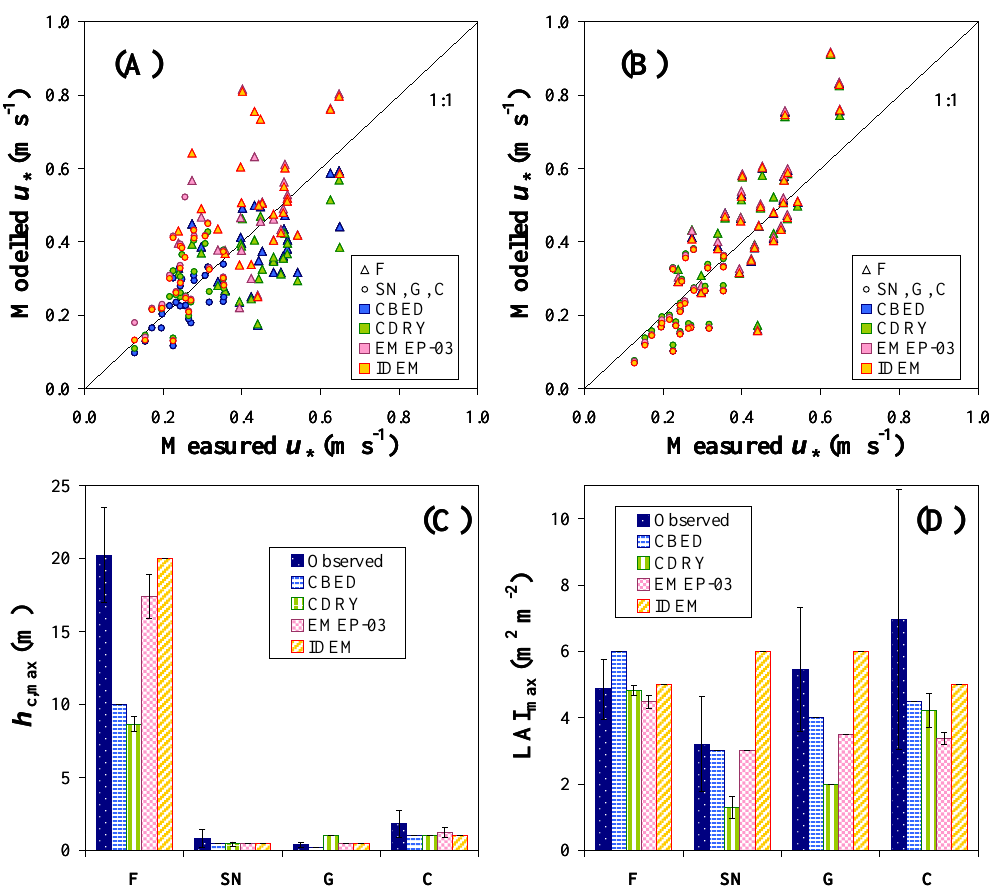
Fig. 1. Comparison of measured u ∗ (long-term means at each observation site) with inferential model estimates, using as input either model default values of h c (A) or measured h c at each site (B) . Panels (A) and (D) : comparison of mean observations and model default values of h c and LAI for the different land use types (F: forests; SN: semi-natural; G: grasslands; C: croplands). Note that the CDRY model uses tabulated ecosystem-specific values of z 0 , and does not require hc as a predictor of z0; thus, for comparabilitys sake, the hc values presented for CDRY in Fig. 1C were actually calculated by multiplying model z 0 by 10, since the other three models all use z 0 = h c